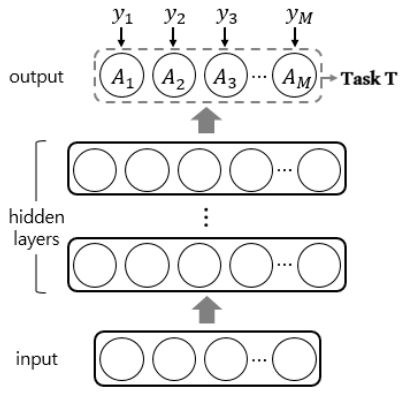
Figure 1. A network structure with single task 𝐓 for recognizing 𝑴 mutually exclusive attributes.